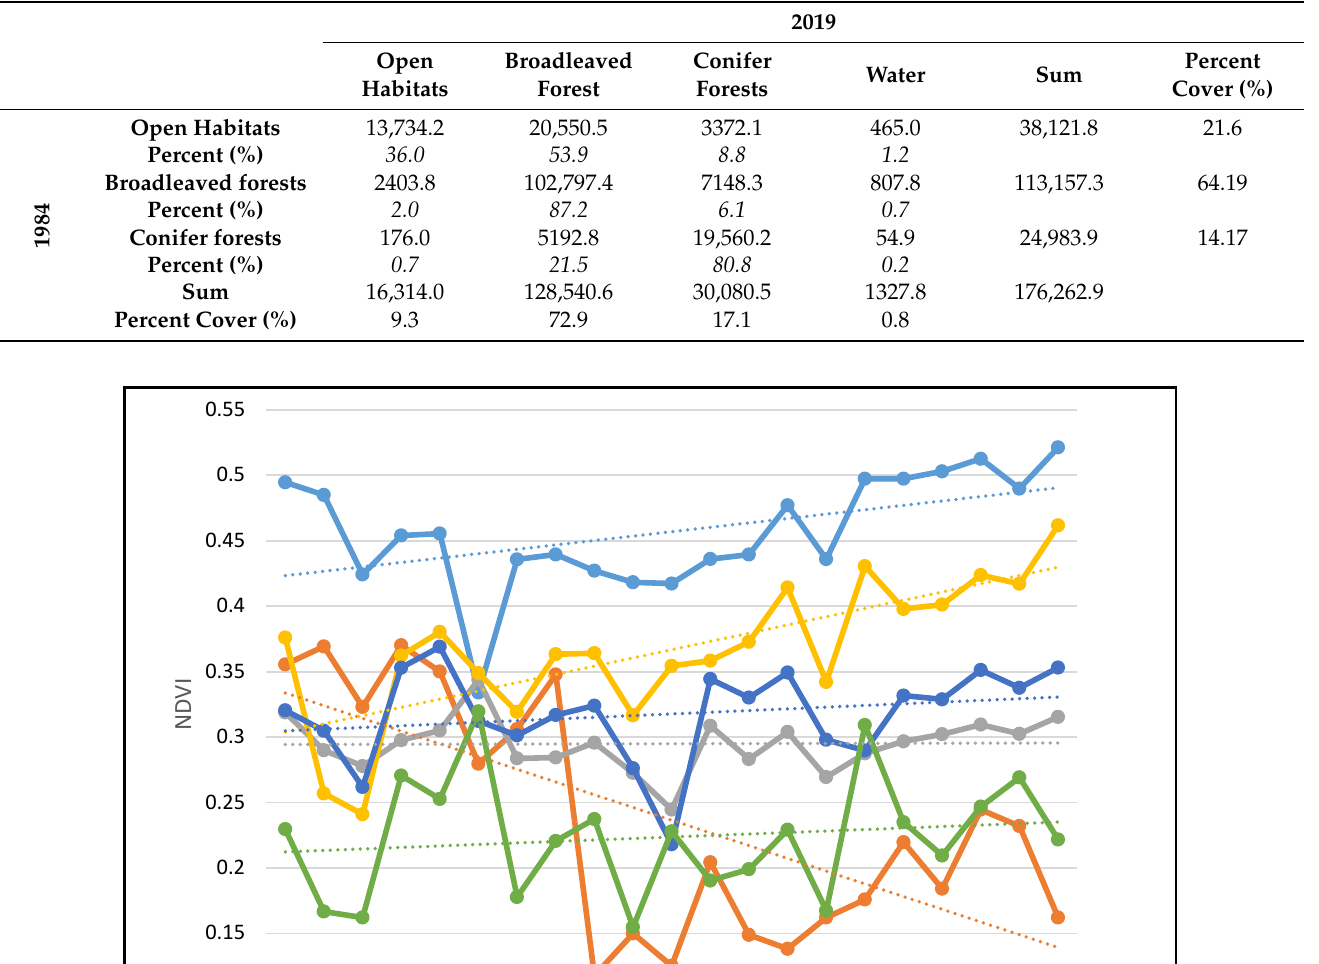
Table 6. Transition Matrix between 1984 and 2019 (all areas are in ha).